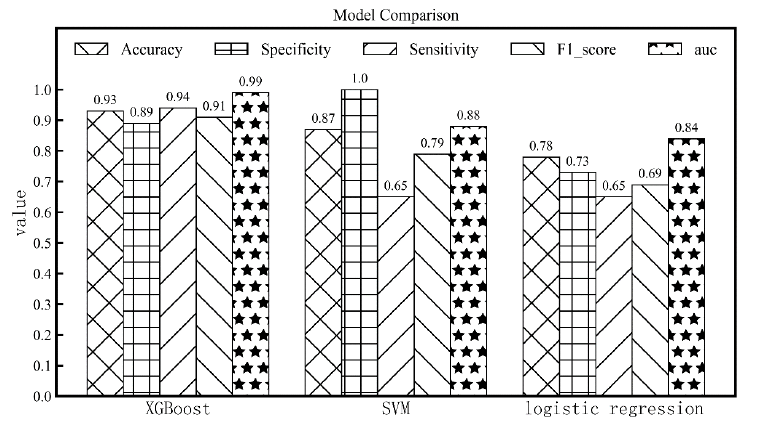
Figure 4. Model comparison among XGBoost, SVM and logistic regression according to accuracy, specificity, sensitivity, F1 score and AUC.